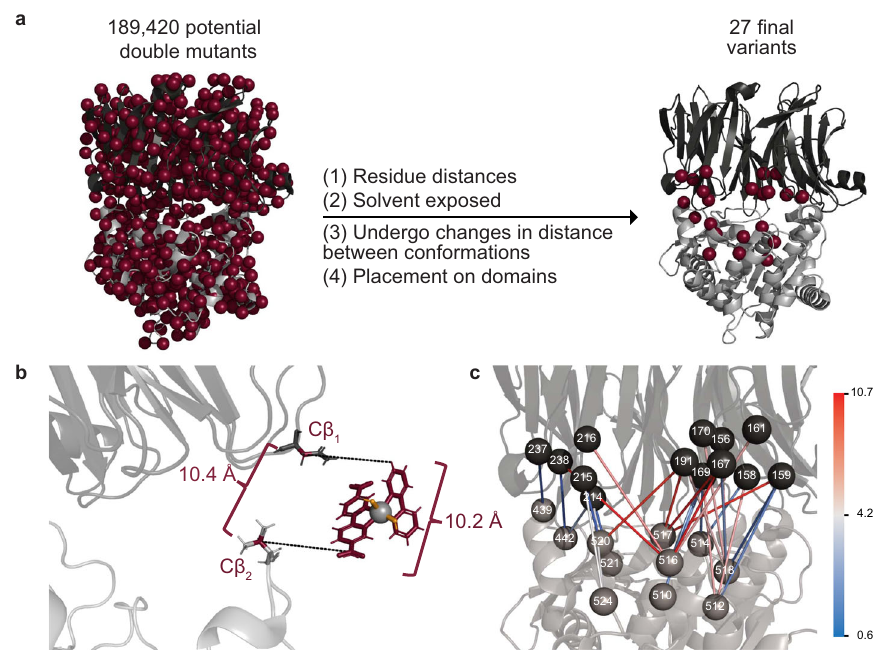
Fig. 2 Design strategy for Bpy-Ala POP variants. a Filtering process used to select sites for Bpy LG pairs. b Distance and geometry requirements for Bpy LG placement were obtained by mapping the structure of a Zn(Bpy) 2 (CCDC:756656) complex onto the Pfu POP structure (PDB ID: 5T88). A distance of 10.5 ± 0.5 Å between the C-5 substituents on the two Bpy ligands and the C β atoms of the selected residues was used to ensure that Zn(BpyAla) 2 complex could be accommodated between the residues. c Locations of the fi nal 27 LG pairs. The spheres represent the positions of the C β atoms of the selected residues on the β -propeller (black) and peptidase (gray) domains and labels represent residue numbers. Lines are drawn between residues in each pair, and the color of the line represents the change in distance between the residues in the open and closed POP conformations. Source data are provided as a Source Data fi